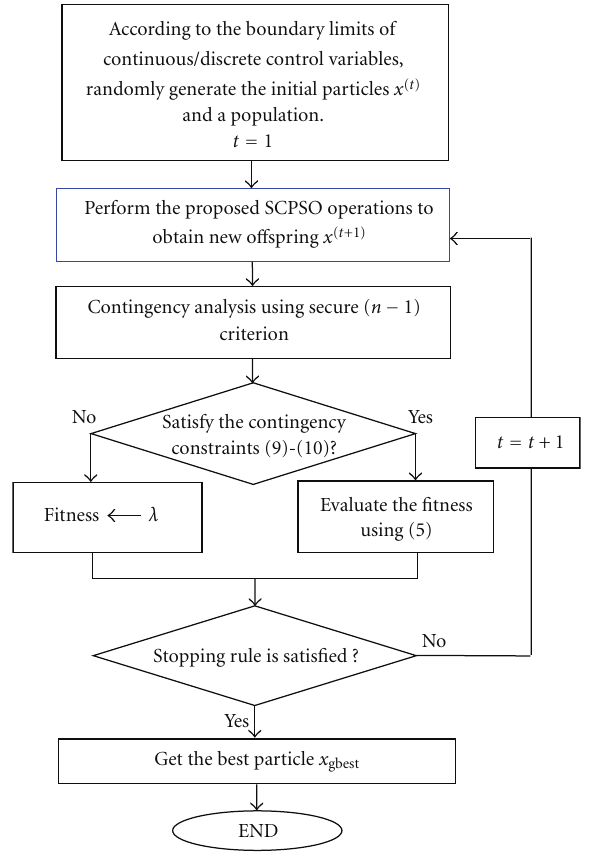
Figure 4: Operating procedures of the proposed SCPSO-based CC-OPF